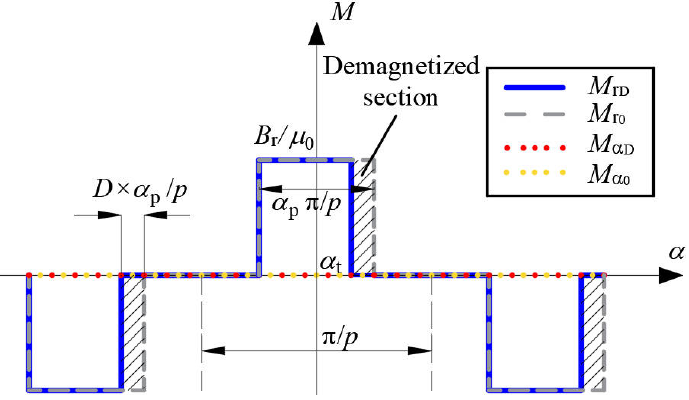
respectively. Their waveforms are shown in Figure 3.